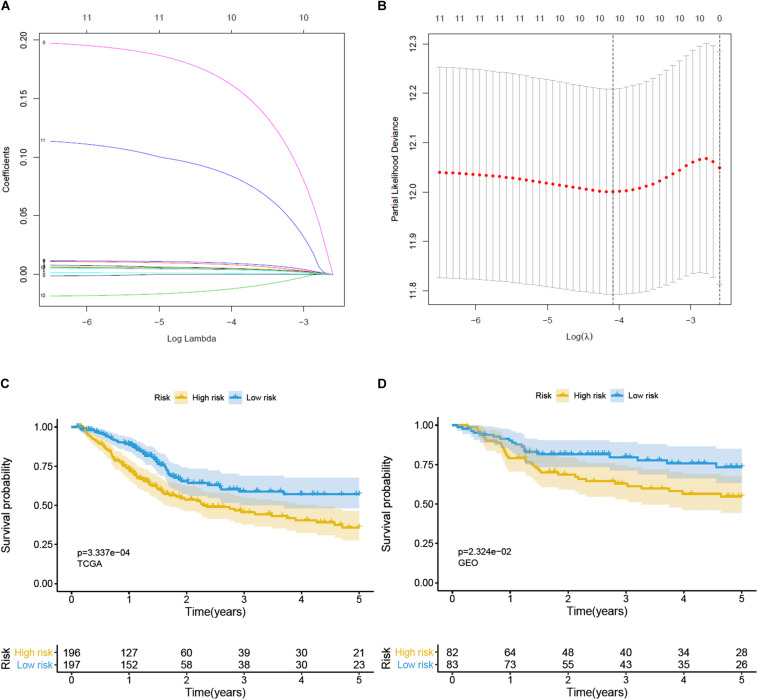
Construction and verification of a prognostic gene signature for BC patients. (A) Lasso coefficient profiles of 12 prognostic genes. (B) Lasso-penalized Cox regression with ten-fold cross-validation obtained 10 prognostic genes by using minimum lambda value. (C) Survival analysis in training set. (D) Survival analysis in validation set.